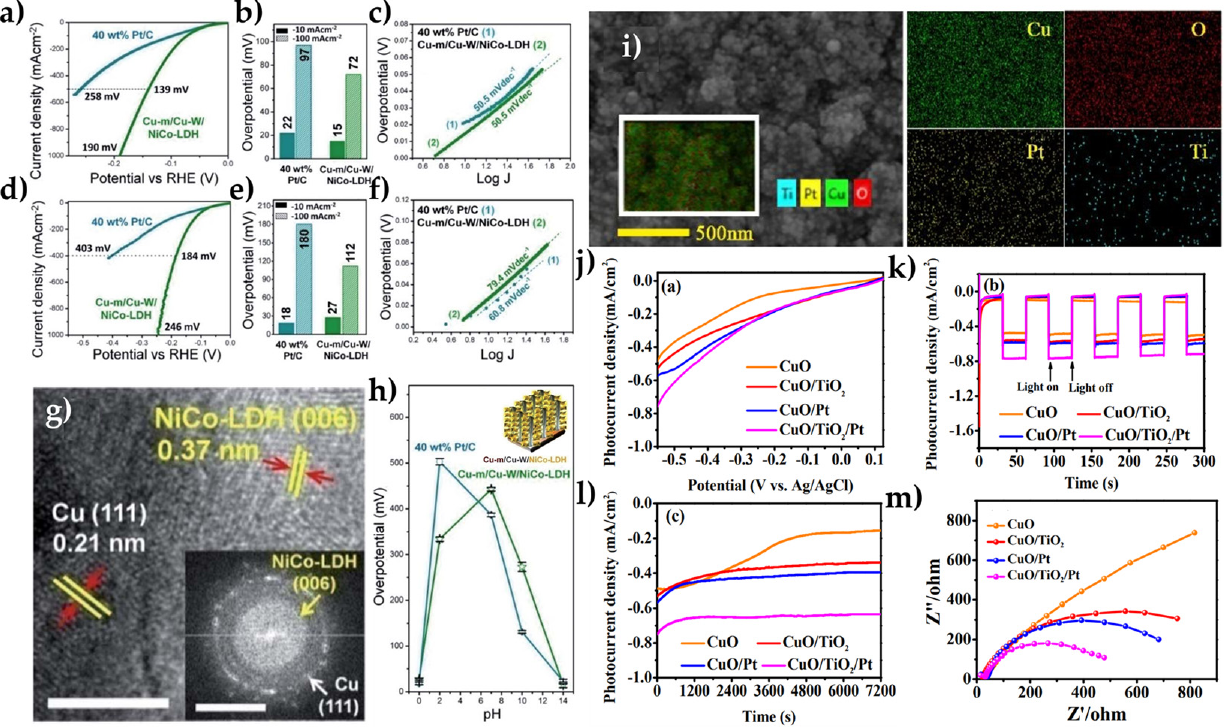
Figure 10. Electrocatalytic HER performance of Cu − m/Cu − W/NiCo − LDH as a competitive catalyst against the state of art 40% Pt/C. Alkaline conditions (1 M KOH) ( a ) HER polarization curves in 1 M KOH (iR − corrected); ( b ) overpotentials at − 10 and − 100 mA cm − 2 ; ( c ) Tafel plots for Cu − m/Cu − W/NiCo − LDH and 40 wt% Pt/C. For acidic conditions (0.5 M H 2 SO 4 ): ( d ) HER polarization curves (iR − corrected); ( e ) overpotentials at − 10 and − 100 mA cm − 2 ; ( f ) corresponding Tafel plots; ( g ) high resolution TEM images of Cu − m/Cu − W/NiCo − LDH; ( h ) Required overpotential across the pH spectrum to reach − 10 mA cm − 2 for Cu − m/Cu − W/NiCo − LDH and 40 wt% Pt/C. Reproduced from Ref. [79] with permission form the Royal Society of Chemistry; Photo − electrochemical HER of CuO with CuO, CuO/TiO 2 , CuO/Pt and CuO/TiO 2 /Pt photocathodes. ( i ) SEM image of the last sample CuO/TiO 2 /Pt is presented with elemental mapping images of Cu, O, Ti and Pt of CuO/TiO 2 /Pt. ( j ) Photocurrent density versus Applied Voltage, with the CuO/TiO 2 /Pt to behave better of all other samples. ( k ) The photo-response of samples measured at − 0.55 V vs. Ag/AgCl under illumination with 30 s light on/off cycles, while ( l ) presents Photocurrent density − time curves measured in 1 M NaOH electrolyte at − 0.55 V vs. Ag/AgCl under simulated sunlight illumination for 2 h, indicating a stable sample and ( m ) Nyquist plots by Electrochemical Impedance Spectroscopy measured at − 0.55 V vs. Ag/AgCl of photocathodes with the CuO/TiO 2 /Pt to has the smaller arc-radius. Reproduced from Ref. [26] with permission from the Royal Society of